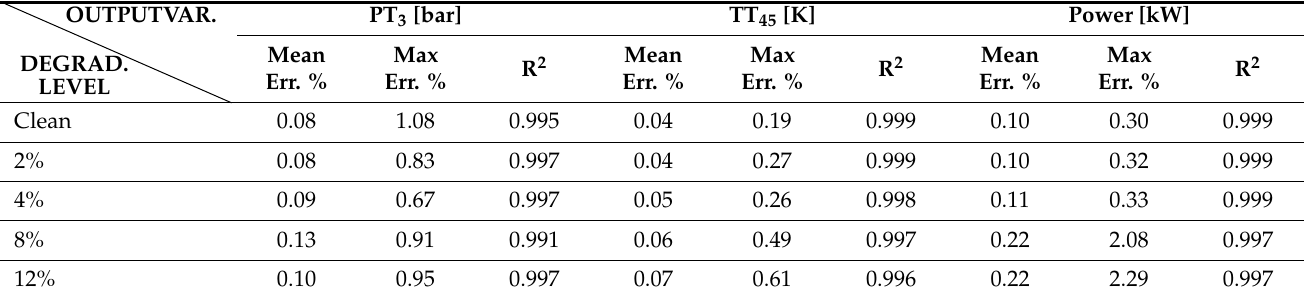
Table 8. Linear model